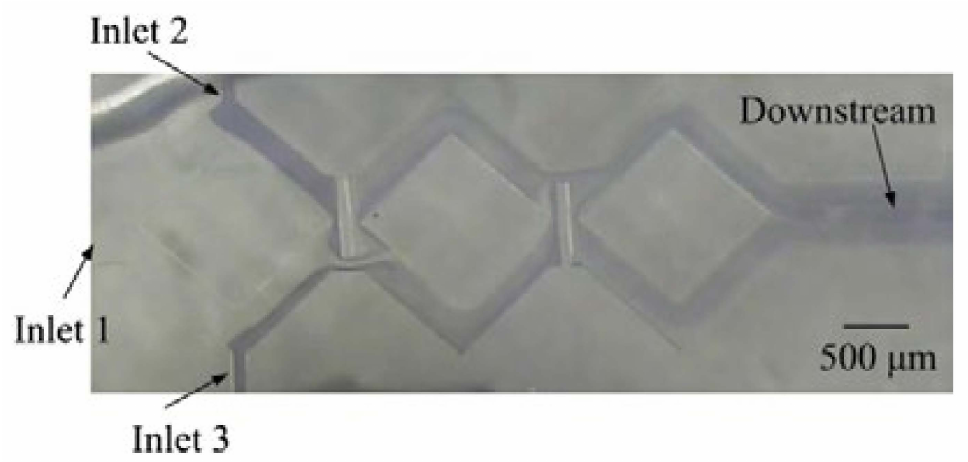
Figure 22. Optical micrographs of fluid mixing in the rhombic micromixer with a gap ratio of 1/8 at Re = 20. The top view image is recorded by a Charge-coupled Device (CCD)